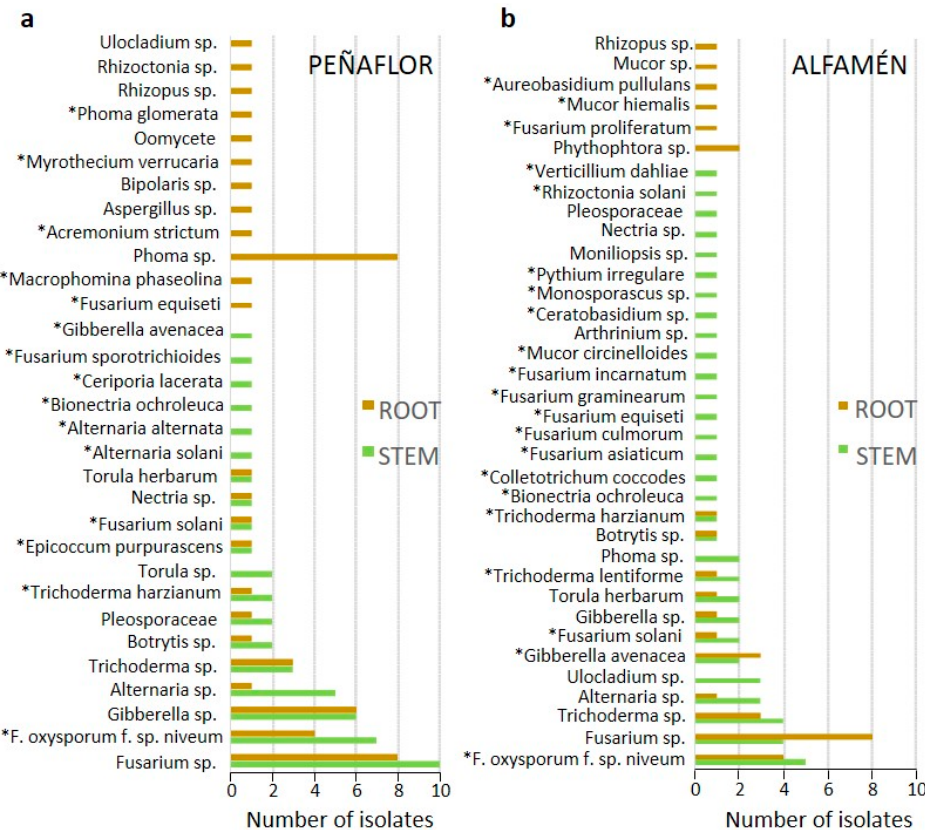
Figure 1. Endophytic fungi (genera and / or species) obtained in the present study in each of the localities sampled. Bars indicate the number of strains obtained per operational taxonomic unit (OTU). Green and brown bars indicate the type of tissue from which they were isolated, stem or root, respectively. *Asterisks indicate that the taxonomic determinations were made from internal transcribed spacer (ITS) sequences; ( a ) Fungi isolated from a commercial field of Peñaflor; ( b ) Fungi isolated from a commercial field of Alfamén.